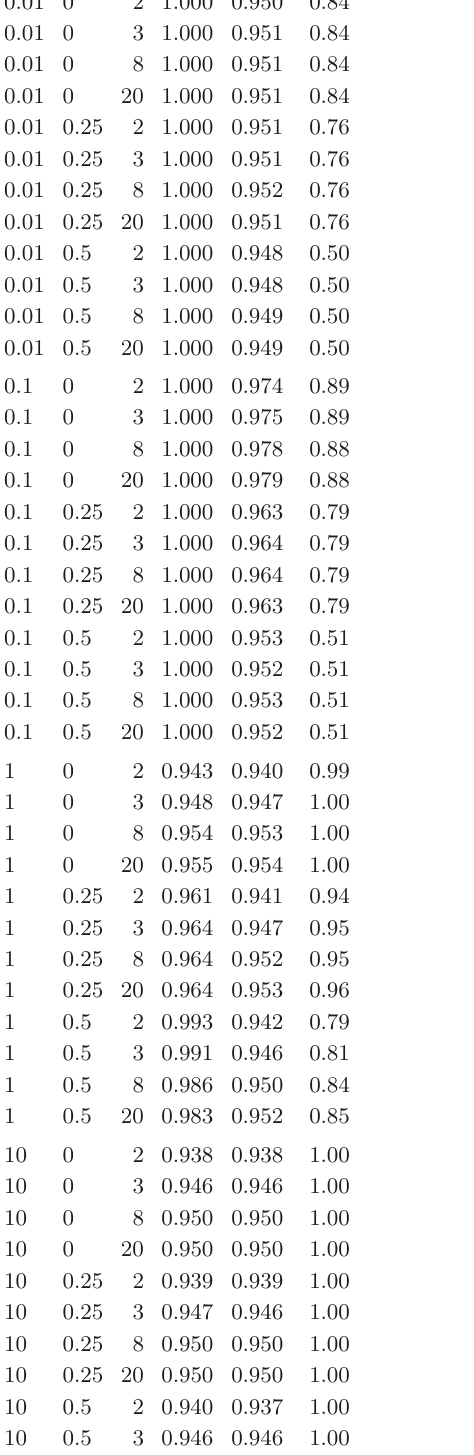
Table 3. Performance results when measuring Y = X 1 + X